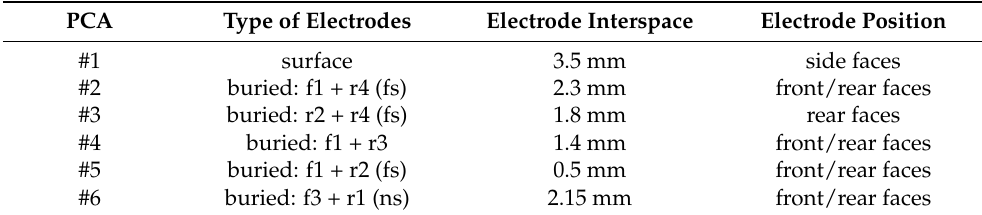
Table 1. Parameters of the photoconductive